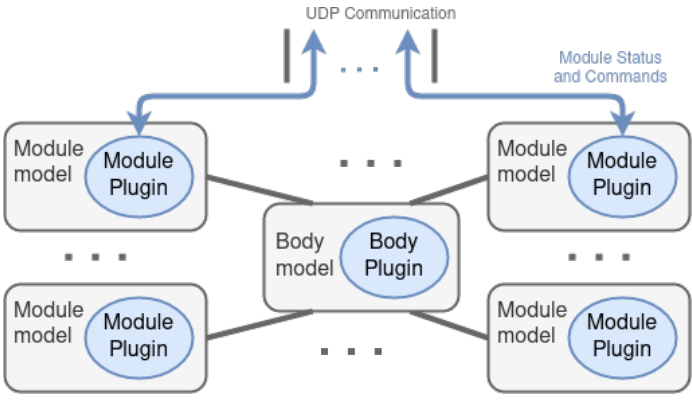
Figure 4. Structure of the digital twin of a robotic